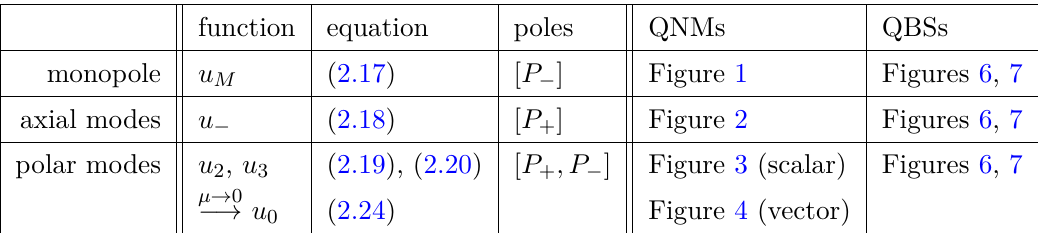
Table 1 . Reference table for the generalized Proca field mode functions and equations, along with the plots of the results for the QNM and quasi-bound state (QBS) spectra. We also indicate which of the poles in (2.5) feature in each mode